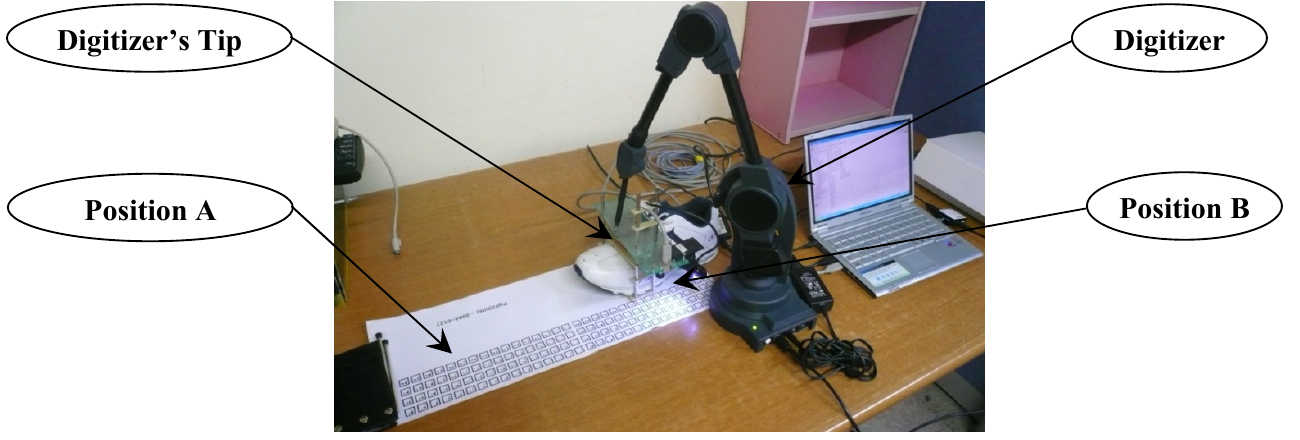
Y axis moving w